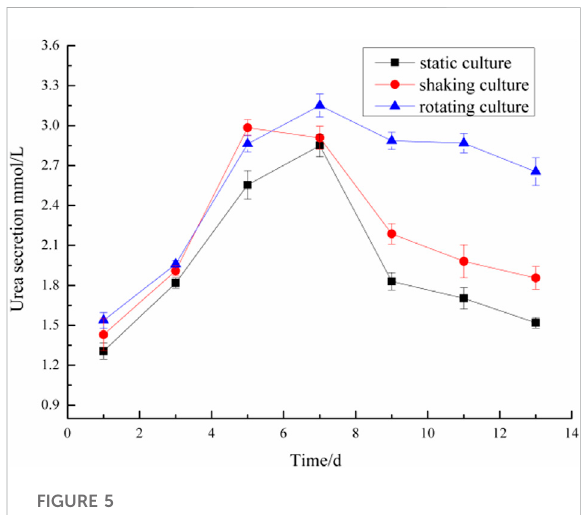
FIGURE 5 Comparison ofureasecretionofmicroencapsulated